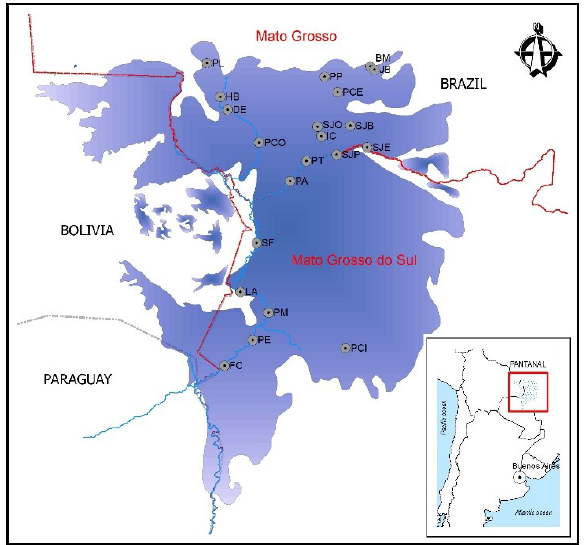
Fig. 2. River gauge/precipitation stations from ANA in the Pantanal